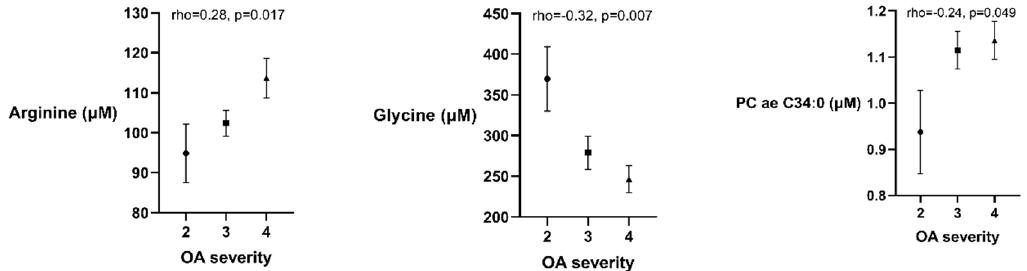
Figure 1. Plots (mean and standard error of the mean) describing the associations between osteoarthritis (OA) radiographic severity and arginine, glycine and phosphatidylcholine with 34 carbon molecules (PC ae 34:0) serum levels (µM). Concentrations of all metabolites are presented as µM.